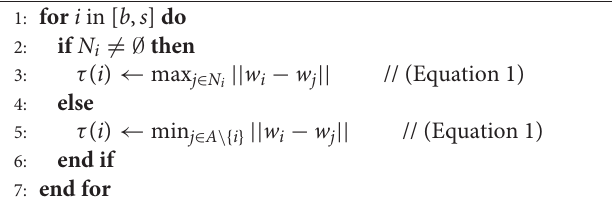
Algorithm 2 . (Associative) SOINN+ Calculation of similarity